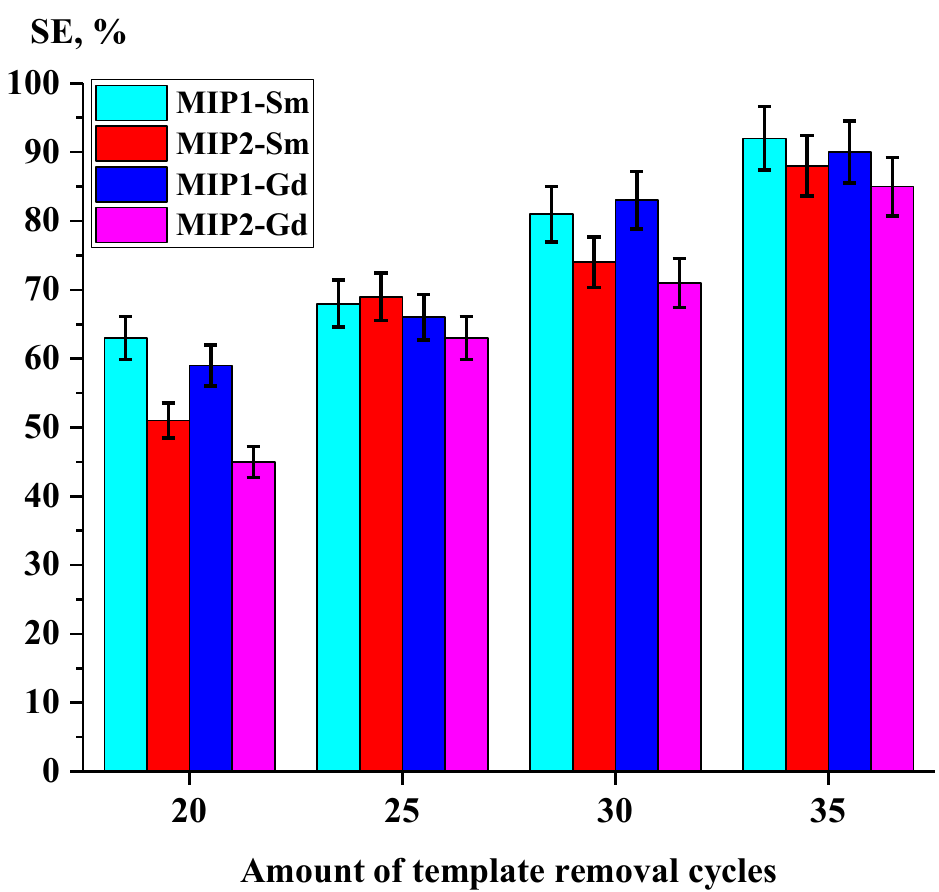
Figure 7. Sorption efficiency of imprinted structures MIP1 and MIP2 depending on amount of template removal cycles.